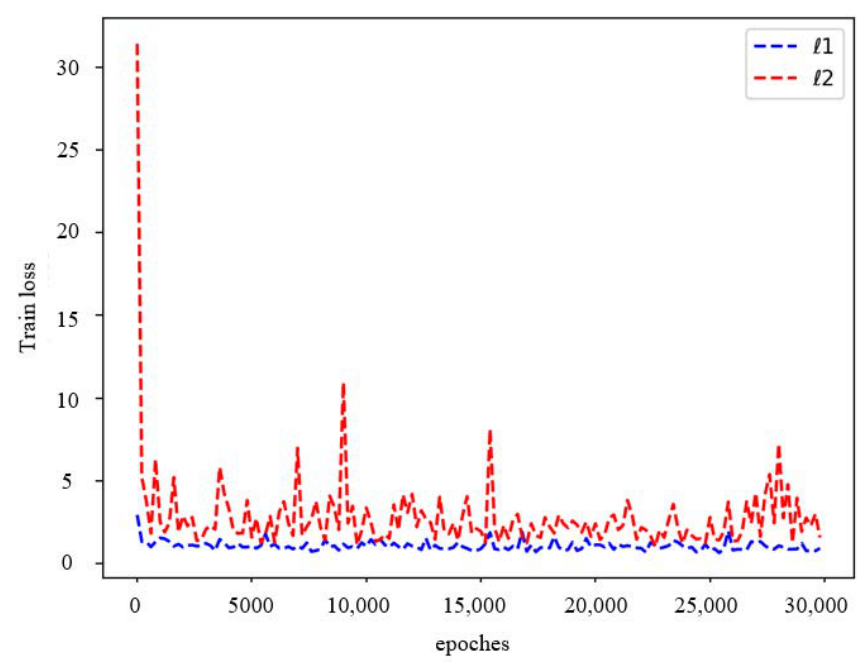
Figure 5. Changes in the loss function when using (cid:96) 1 and (cid:96) 2 in the training